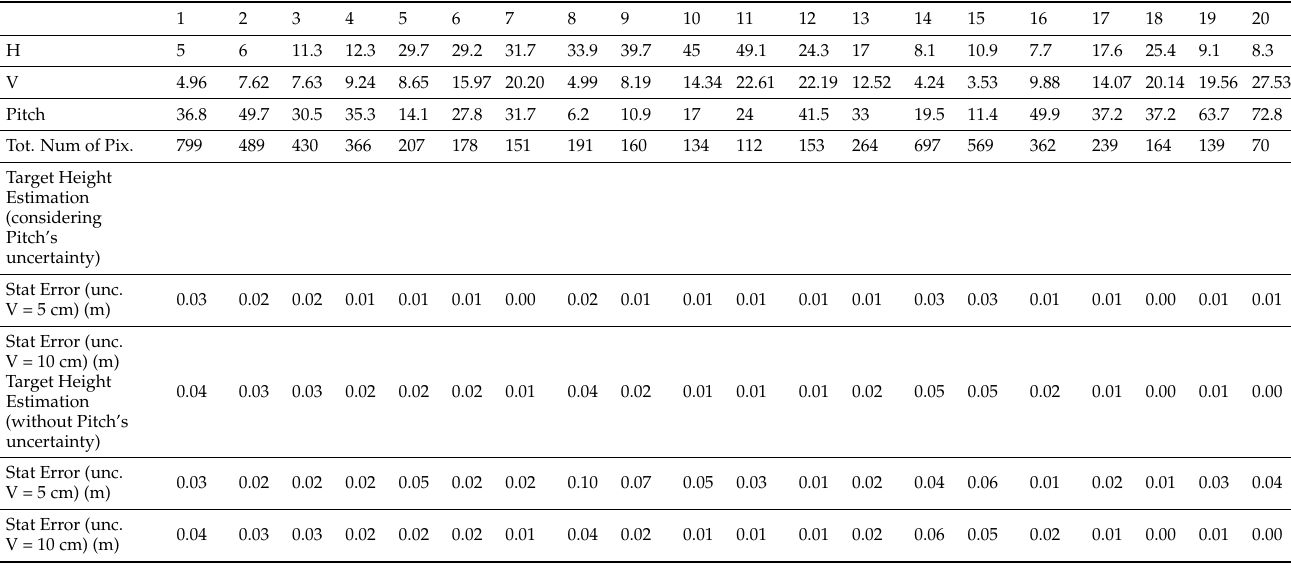
Table 2. 20 cases with a random position of the UAV. The table reports the parameters (pixels upwards and downwards for image center, pitch angle, and horizontal camera-to-target distance) with a target of 1.80